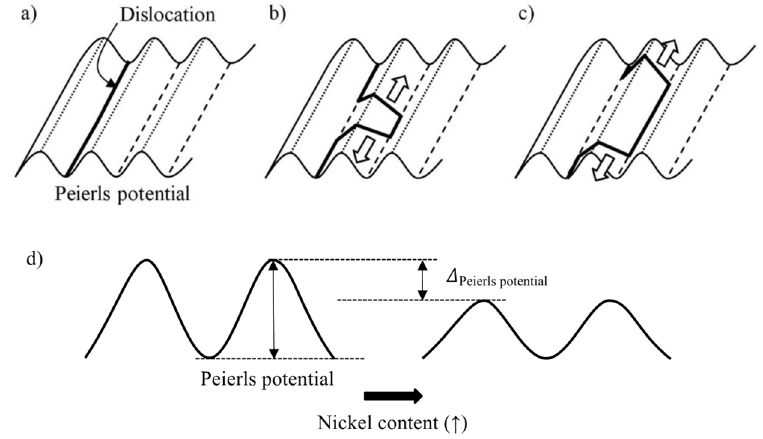
Figure 6. Kink pair nucleation and expansion mechanism moving a screw dislocation across the Peierls potential from one energy valley to the next. ( a ) Original position of screw dislocation aligned to a Peierls valley. ( b ) Activation of a kink pair partially crossing the Peierls peak. ( c ) Expansion of the kink pair under low stress. ( d ) Effect of nickel alloying lowering the Peierls potential and facilitating kink crossing.